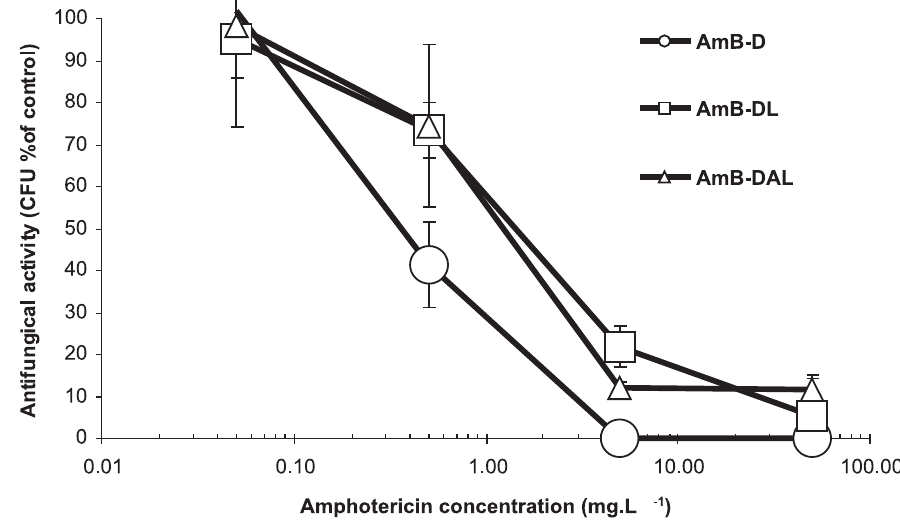
FIGURE 3 – Average of percentage and standard desviation of CSR from Ct under action of AmB-D , AmB-DL or AmB-DAL,